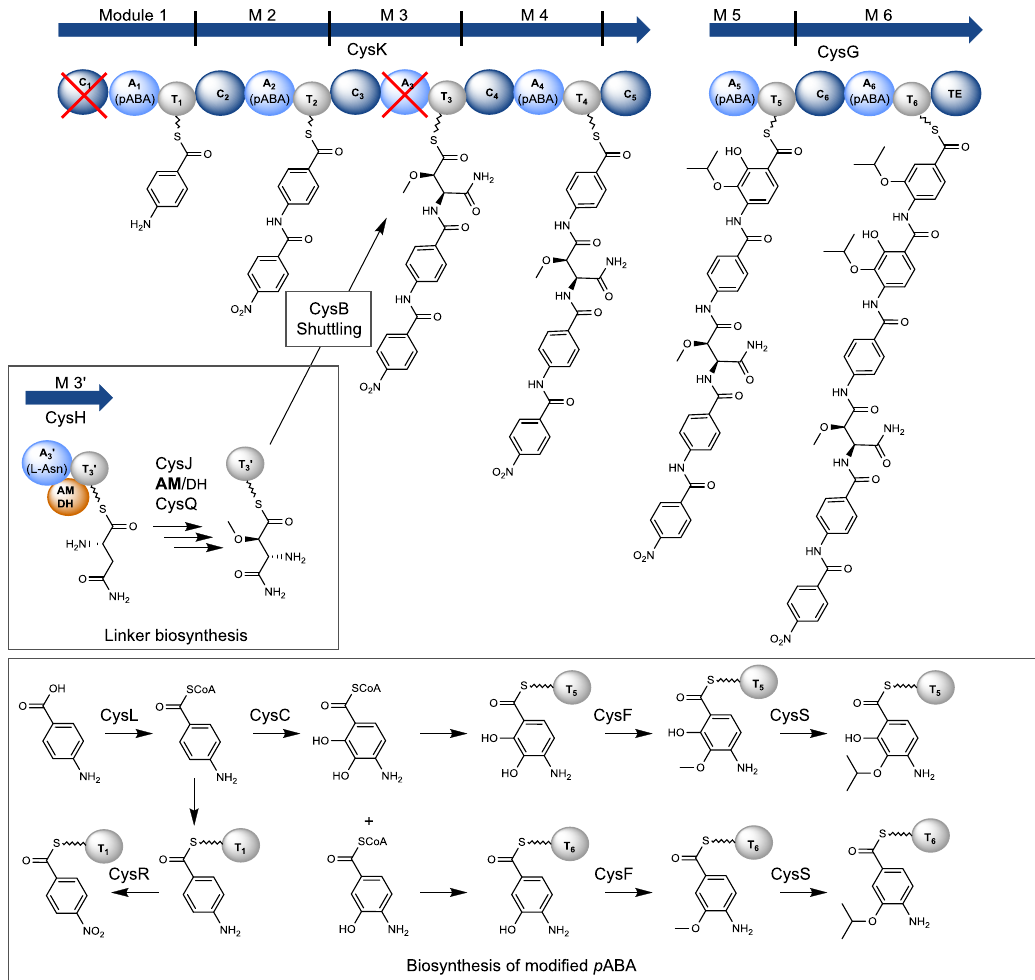
Fig. 7 Revised biosynthesis of cystobactamids on the example of Cys919-1. C: condensation domain (dark blue sphere), A: adenylation domain (light blue sphere), T: thiolation domain (gray sphere), TE: thioesterase domain (dark blue sphere), AMDH: aminomutase dehydratase domain (orange sphere), red cross: inactive domains. Biosynthesis of the α -methoxy- L -isoasparagine linker moiety is described in more detail in Fig. 5. The 6-modular assembly line is encoded by cysK and cysG (blue arrows). CysR converts p ABA to p NBA in trans or after product release from the assembly line. Biosynthesis of 2- isopropoxyl- p ABA and 2-isopropoxyl-3-hydroxy- p ABA is presumably catalyzed by CysC, CysF, and CysS. p ABA is incorporated by M 1 and M 2, respectively. The linker moiety is transferred from T 3 ’ (CysH) to T 3 (CysK) by CysB (see Fig. 6). Another p ABA is incorporated by M 4. Two tailored p ABAs are incorporated by M 5 and M